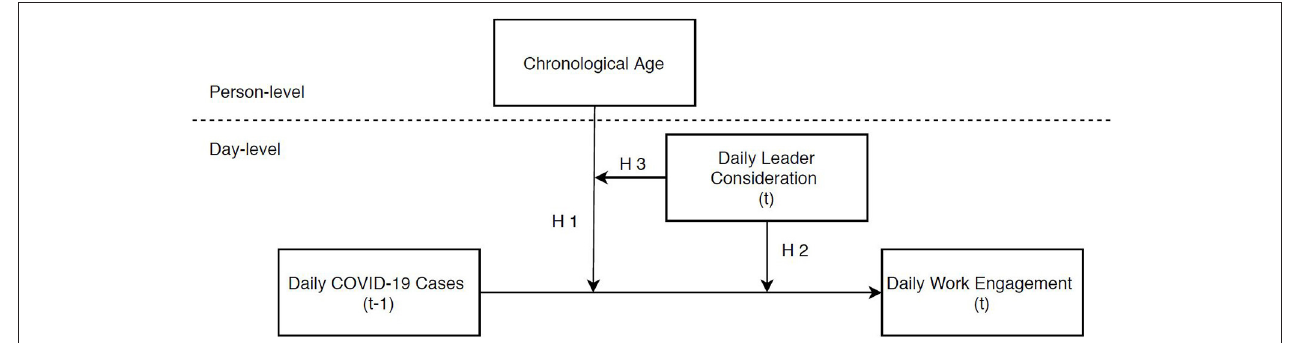
FIGURE 1 | Conceptual